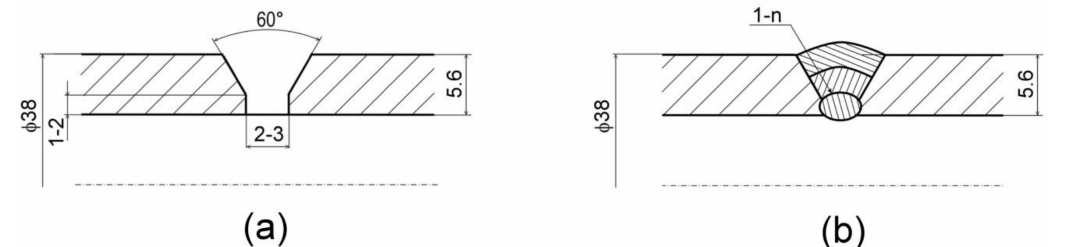
Figure 1. The preparation of welding edges ( a ) and sequence of welding passes ( b ). All dimensions are in mm. The “n” represents the number of welding passes in range from 2 to